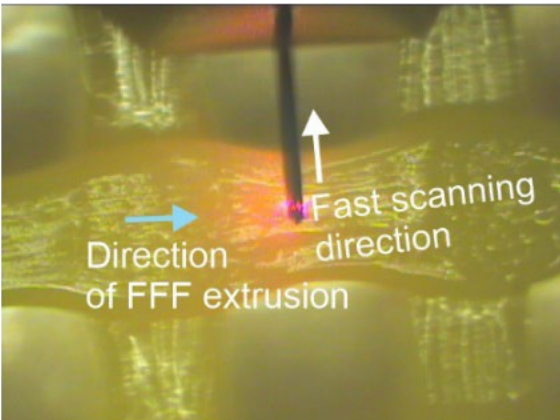
Figure 8. Fast scanning direction relative to the direction of FFF extrusion, as used for obtaining the AFM scans shown in Figures 9 and 10.